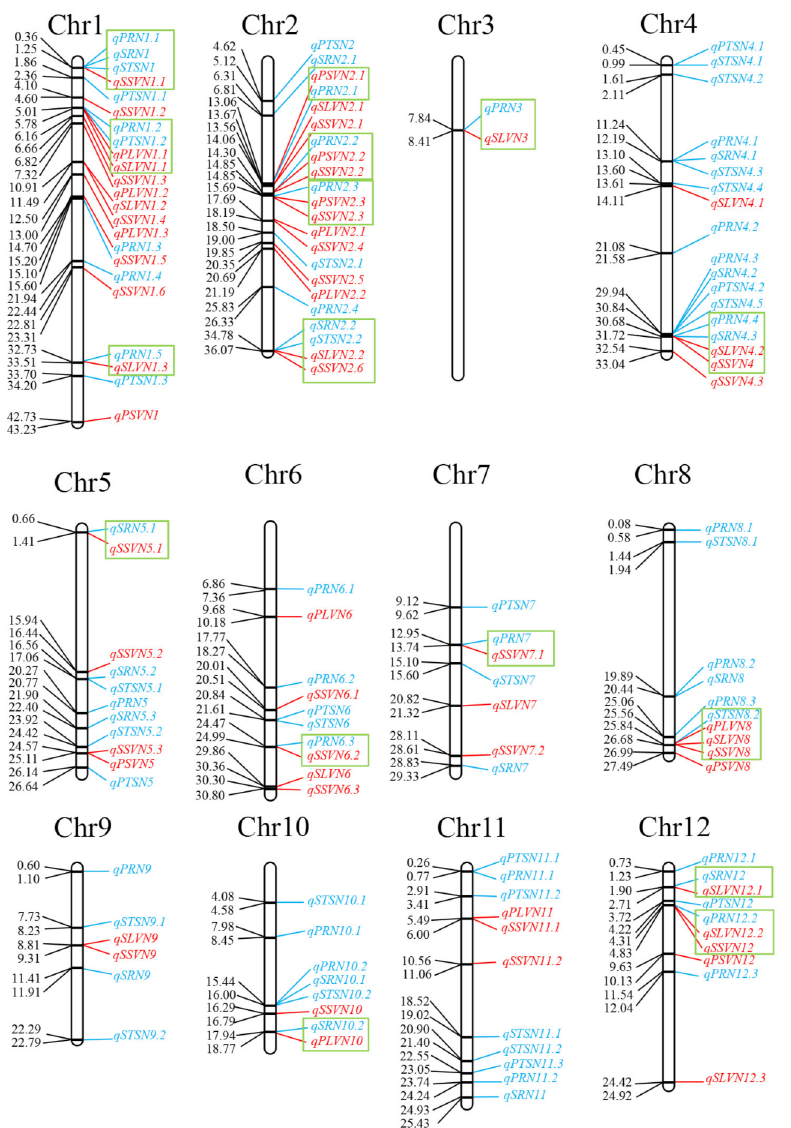
Figure 4. Distribution of QTL identified in the 440 panel. Red and blue indicate the QTL affecting flow- and sink-related traits, respectively. Green rectangles represent the QTL regions simultaneously affecting flow- and sink-related traits. Numbers on the chromosome indicate the physical position of each